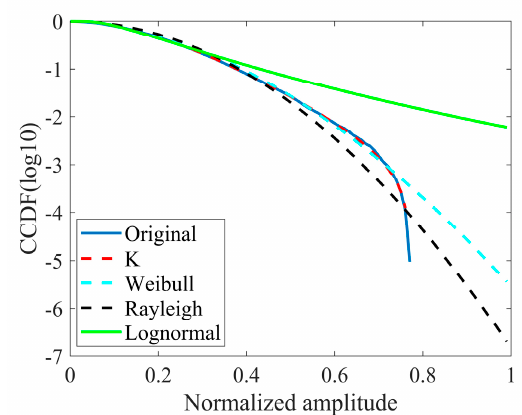
Figure 4. The fitting results of original clutter amplitude (range bin = 300, CNR = 18.97dB).